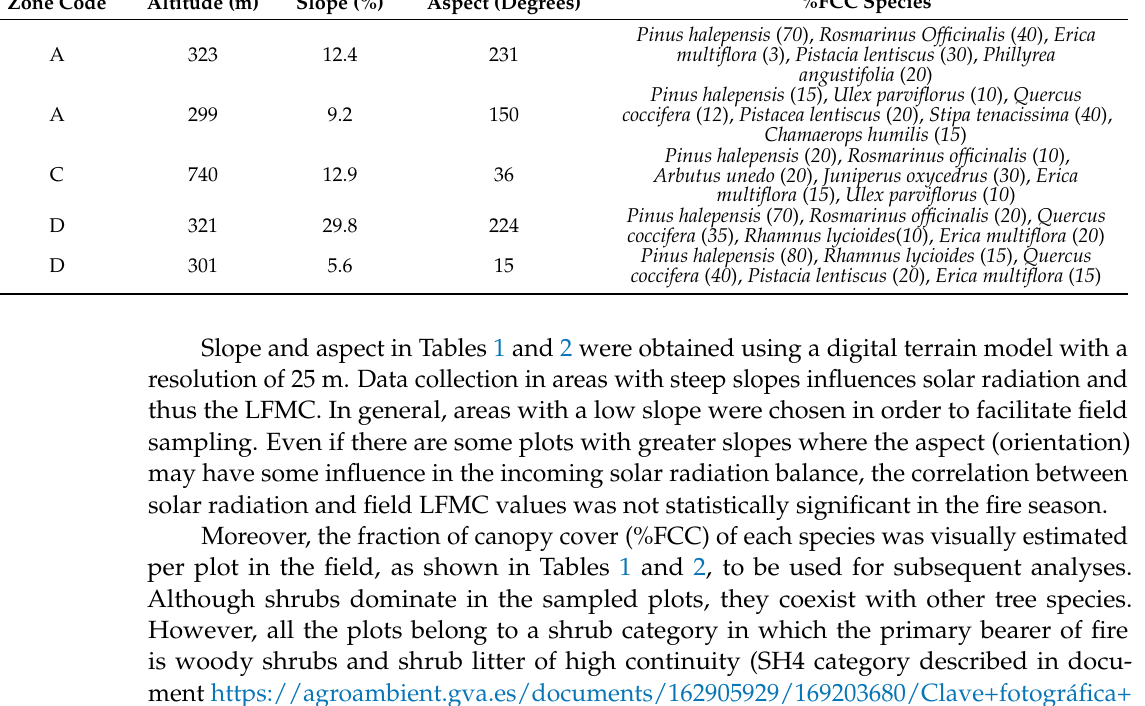
Table 2. Description of the validation plots. The attributes are the following: plot number and zone code (see Figure 1), altitude and slope (in center of the plot), aspect (degrees), the names of the most representative species per plot, and their specific %FCC. Data were collected in the same time period as in calibration plots described in Table 1. Plot